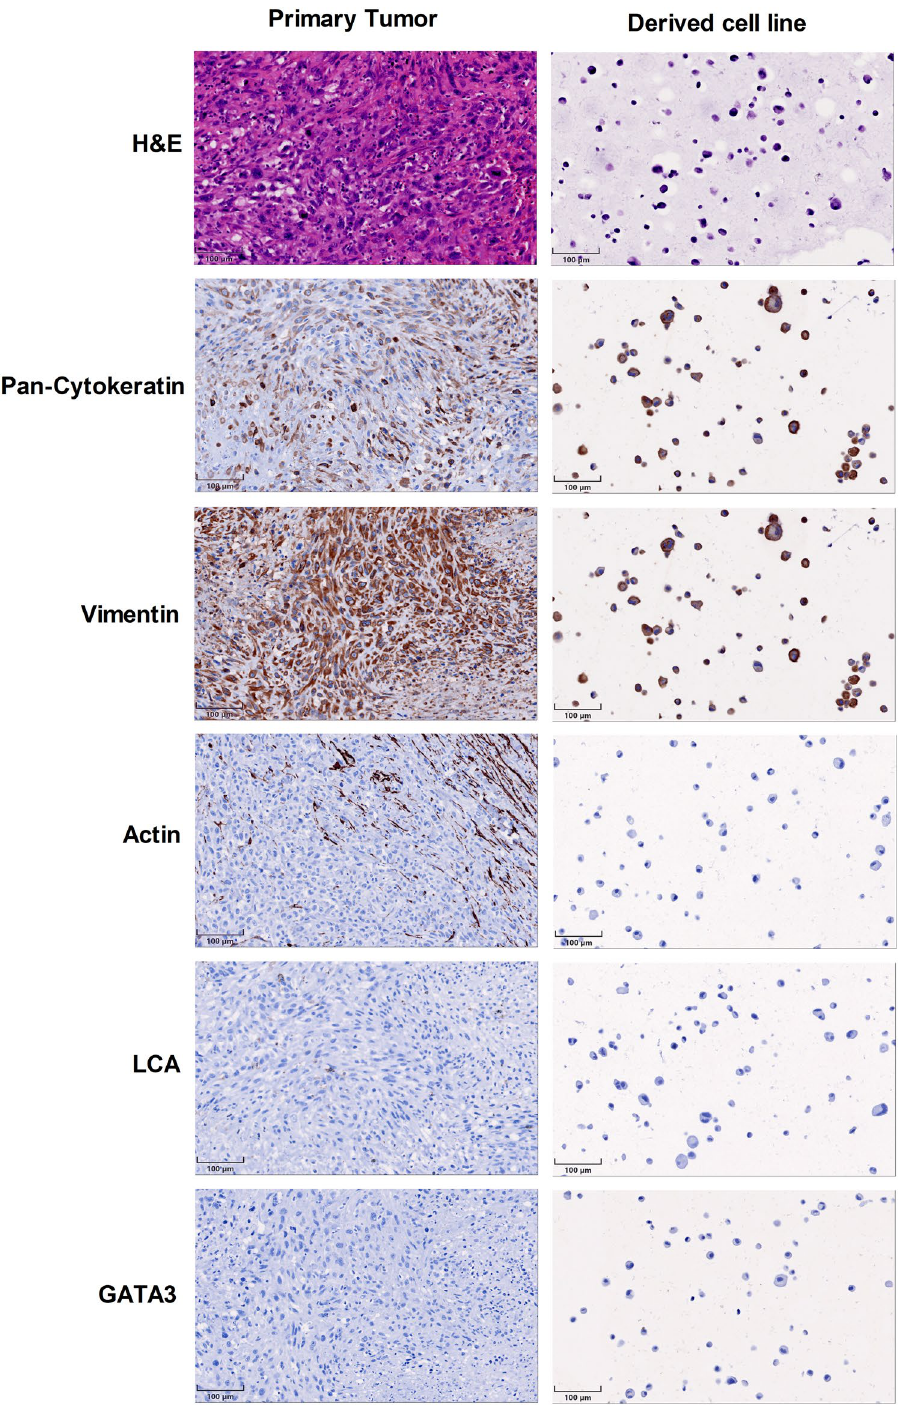
Figure 2. MaS-3 shows similar expression pattern as original tumour tissue Immunohistochemistry of MaS-3 cell line and original 3D cell culture. (Supplementary Figure 4). Over time the spheroids became more compact (Fig. 5A) and decreased in volume. The volume reduction as specifically observable in the higher seeding concentrations (Fig. 5B). Calcein AM and Propidium iodide staining revealed that after 96 h cells were still growing in a viable structure, surrounded by some dead cells. In higher seeding concentrations the core also showed a decreased cell viability (Fig. 5A).